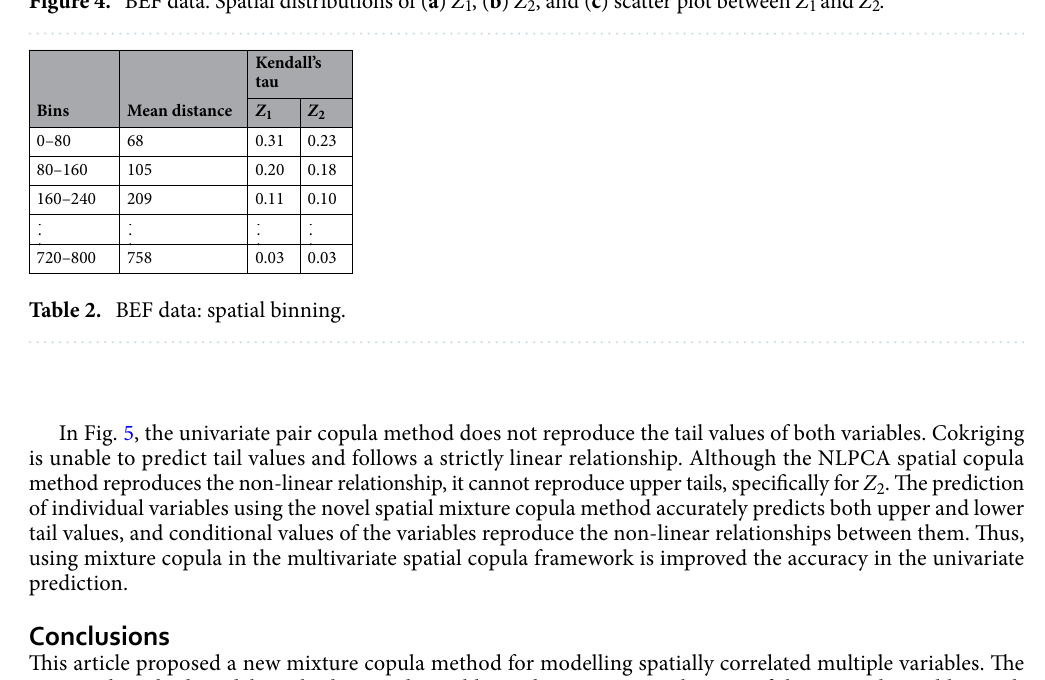
Figure 4. BEF data. Spatial distributions of ( a ) Z 1 , ( b ) Z 2 , and ( c ) scatter plot between Z 1 and Z 2 .